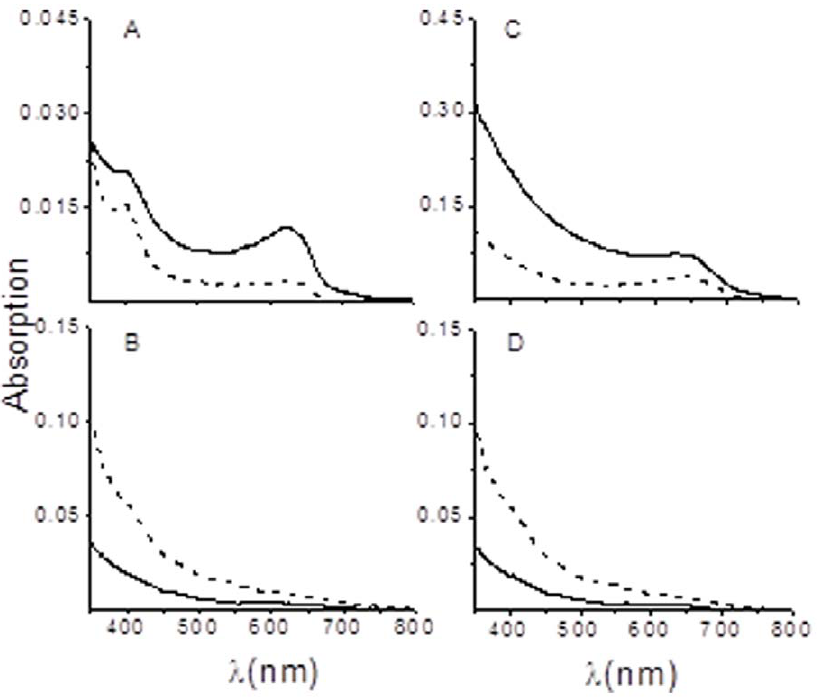
Figure 8. Assay of DOHH for phycocyanin a -84 lyase and phycoerythrocyanin a -84 lyase activities. Absorption spectra of acceptor proteins, CpcA and PecA, after treatment with PCB in the presence (–) or absence (–) of DOHH, and purification by Ni 2 + affinity chromatography. (A) Assay for the attachment of PCB to CpcA in the additional presence of the lyase, CpcE. (B) Assay for the attachment of PCB to CpcA in the additional presence of the lyase, CpcF; (C) Assay for the attachment of PCB to PecA in the additional presence of the lyase, PecE. (D) Assay for PCB isomerizing to PVB and attachment to PecA in the additional presence of the lyase, PecF. All reactions were carried out in E. coli (see Materials and methods for